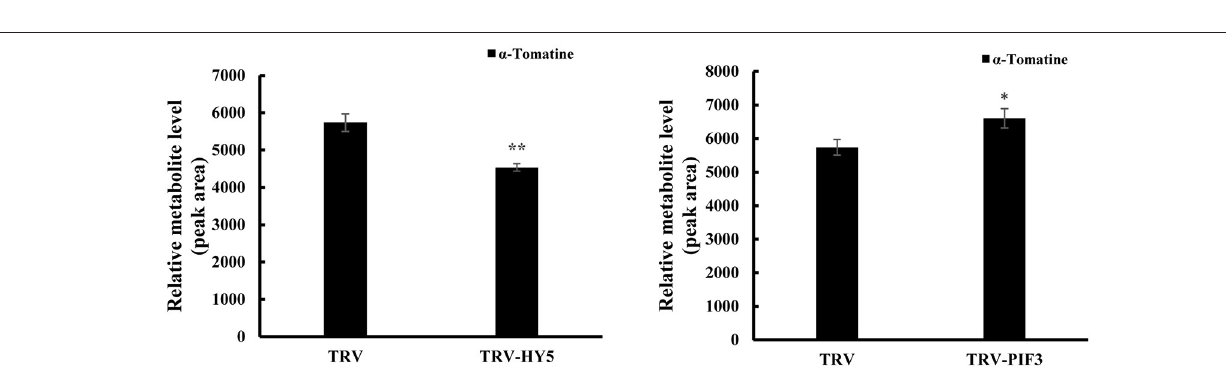
HPLC-MS/MS, which showed a 21% reduction in tomatine in TRV- SlHY5 -infected leaves compared to TRV-infected leaves, and a 16% increase in tomatine in leaves in which PIF3 was silenced ( Figure 4